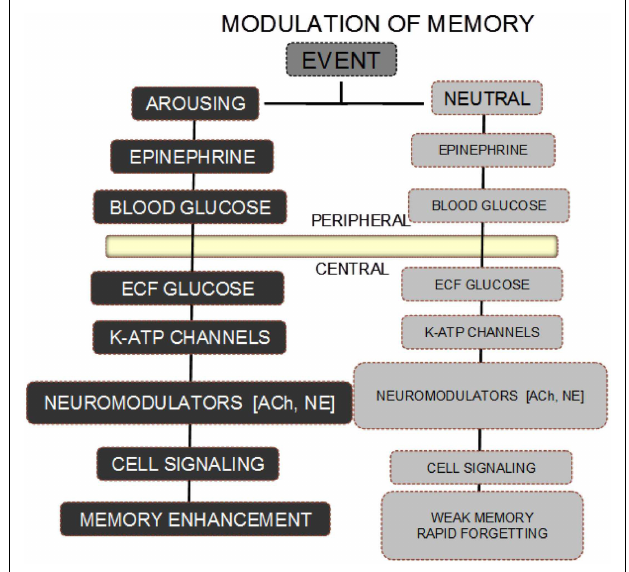
FIGURE 1 | Scheme for modulation of memory by epinephrine and glucose. A neutral event fails to initiate the release of epinephrine, resulting in absence of the biological steps downstream from an increase in circulating epinephrine levels. As a result, the memory for a neutral event is weak and rapidly forgotten. In contrast, an arousing event results in increases in epinephrine released from the adrenal medulla.The epinephrine in turn initiates glycogen breakdown to glucose in the liver, with increases in blood glucose levels. Glucose enters the brain, providing support for neurotransmitter release, activation of intracellular signals responding to receptor binding, with eventual enhancement of